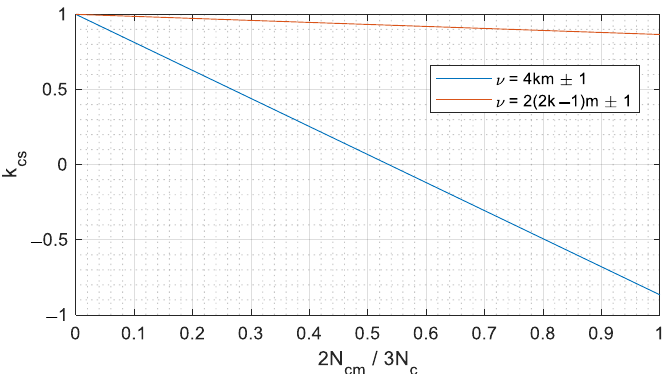
Figure 4. Influence of turns ratio on factor k cs.